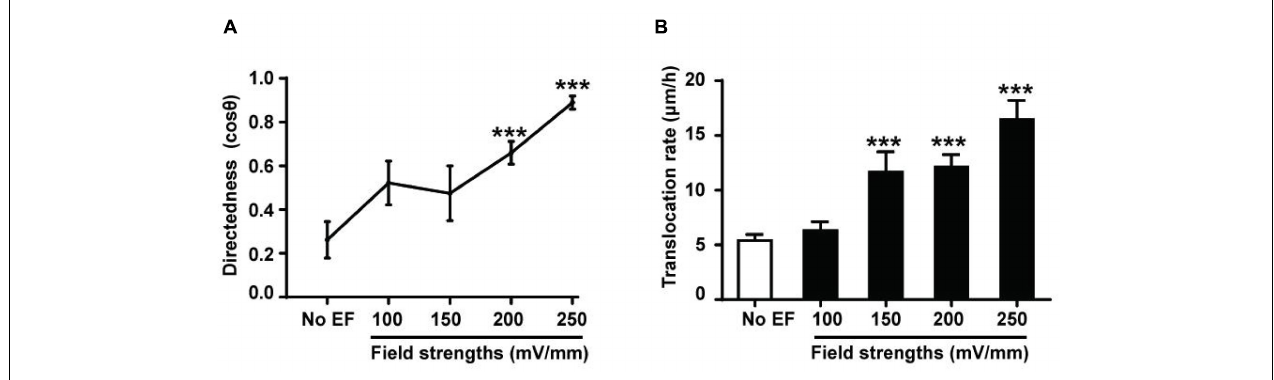
FIGURE 2 | Voltage dependence of EF-directed migration and enhanced migration rate of human renal tubular epithelial cells. Directedness and rate of cell migration of HK-2 cells cultured in EFs (see section “Materials and Methods”) were calculated during a 6-h period. Cathodal migration of the cells was voltage dependent (A) , and an increase in the migration rate was also voltage dependent (B) . The cell numbers included in the analysis at individual field strengths of 0–250 mV/mm are 28–81. *** P < 0.001, compared to the control with no EF (0 mV). Values are shown as means ± SEM. Erk- i-, p38-i- and Akt-i-untreated cells ( Figure 5 ).